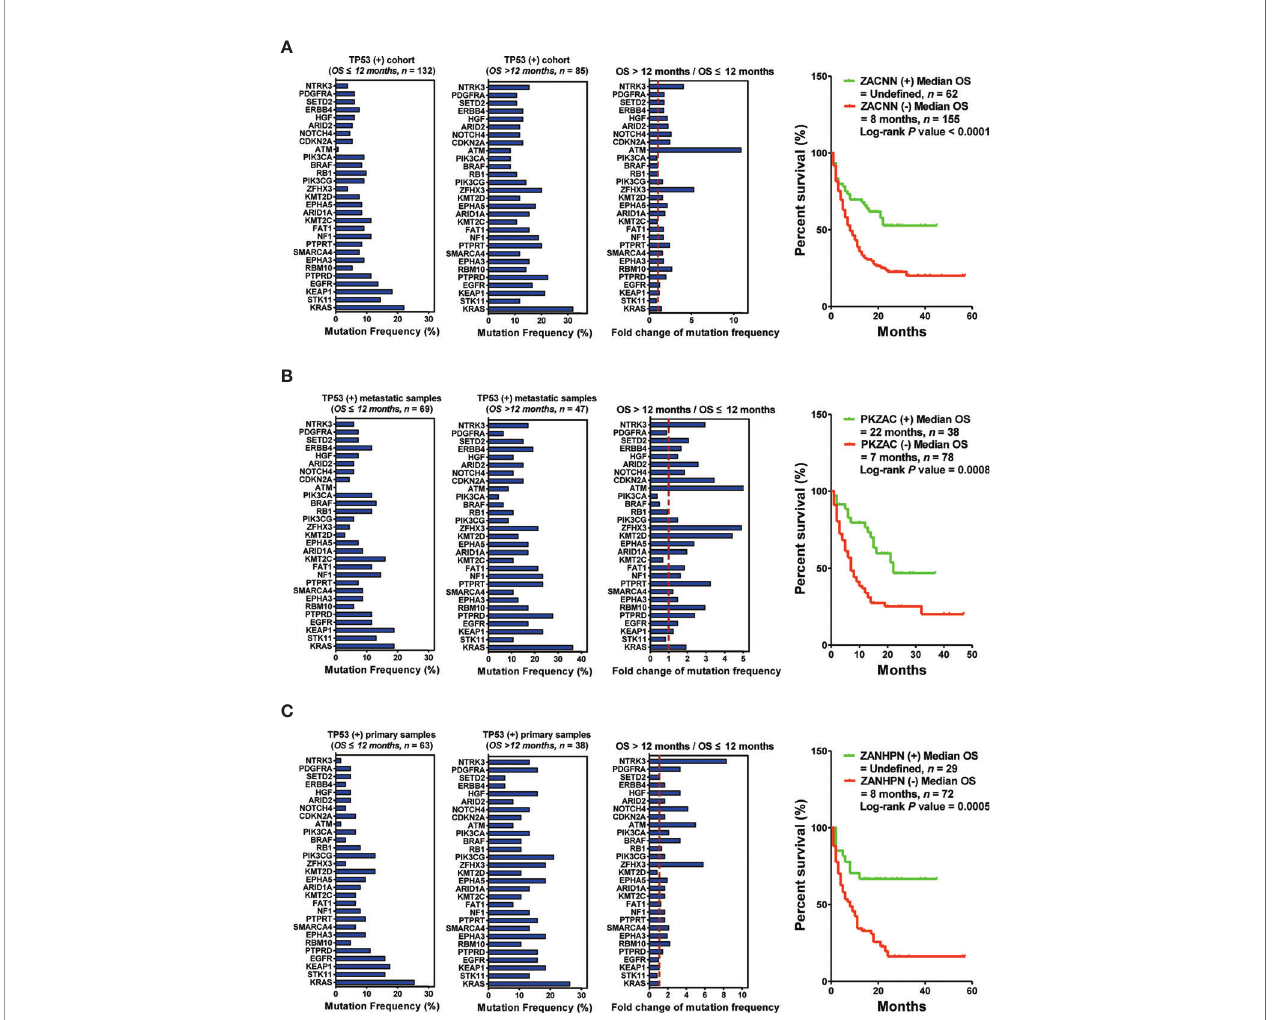
FIGURE 4 | Biopsy lesion type affects the stratifying factors of immunotherapy in patients harboring TP53 (+) mutation. (A) Left: Mutation frequency of the top 30 genes in the TP53 (+) cohort with OS ≤ 12 months. Mutation frequency of the top 30 genes in the TP53 (+) cohort with OS >12 months. Fold change in mutation frequency with OS >12 months/OS ≤ 12 months for the top 30 genes. Right: Kaplan – Meier curve analysis of OS strati fi cation using the ZACNN ( ZFHX3 , ATM , CDKN2A , NOTCH4 , and NTRK3 ) mutation status. (B) Left: Mutation frequency of the top 30 genes in the TP53 (+) metastatic sample cohort with OS ≤ 12 months. Mutation frequency of the top 30 genes in the TP53 (+) metastatic sample cohort with OS >12 months. Fold change in mutation frequency with OS >12 months/OS ≤ 12 months for the top 30 genes. Right: Kaplan – Meier curve analysis of OS strati fi cation using the PKZAC ( PTPRT , KMT2D , ZFHX3 , ATM , and CDKN2A ) mutation status. (C) Left: Mutation frequency of the top 30 genes in the TP53 (+) primary sample cohort with OS ≤ 12 months. Mutation frequency of the top 30 genes in the TP53 (+) primary sample cohort with OS >12 months. Fold change in mutation frequency with OS >12 months/OS ≤ 12 months for the top 30 genes. Right: Kaplan – Meier curve analysis of OS strati fi cation using the ZANHPN ( ZFHX3 , ATM , NOTCH4 , HGF , PDGFRA , and NTRK3 ) mutation